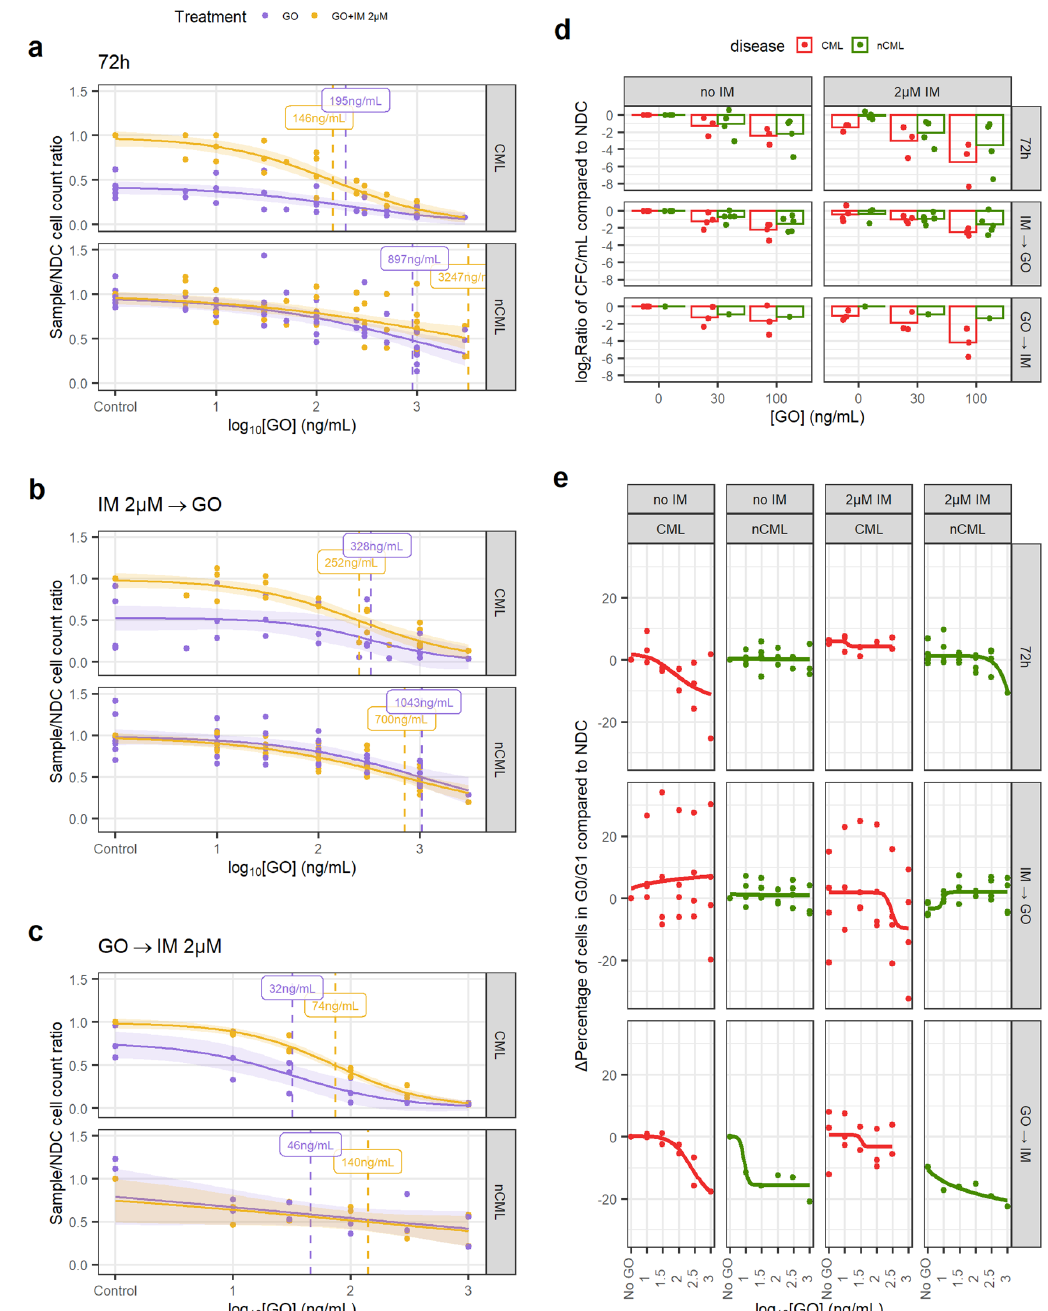
Figure 3. GO is effective at eradicating CML CD34 + cells. ( a ) Dose–response curves for the GO 72 treatment regimen. ( b ) Dose–response curve for the GO IMGO treatment regimen. ( c ) Dose–response